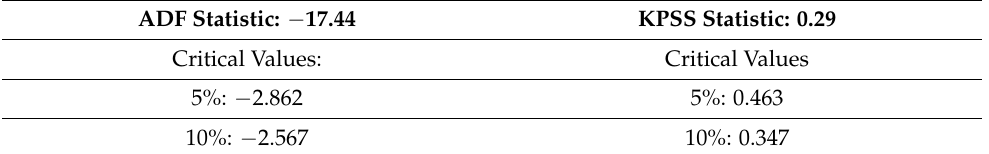
Table 3. AugmentedDickeyFuller(ADF)andKwiatkowski–Phillips–Schmidt–Shin(KPSS)analysis results.